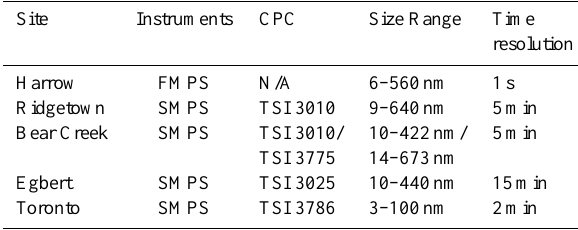
Table 1. Particle number and size distribution measurement param- eters for the five sites during the BAQS-Met